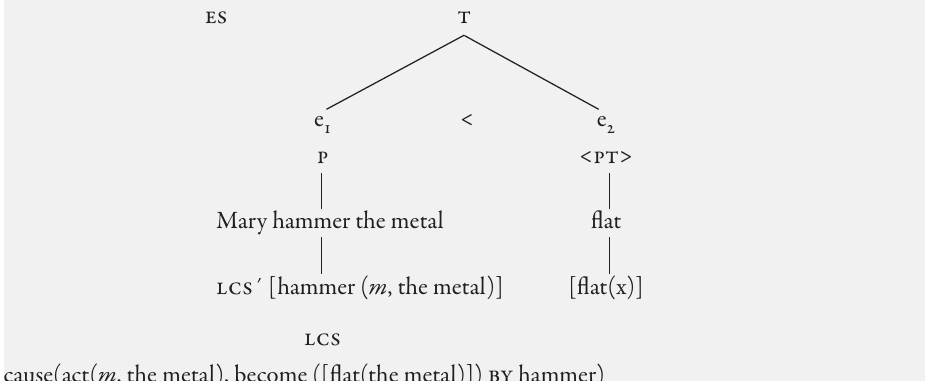
Figura 3 . Rappresentazione di una ‘struttura eventiva’